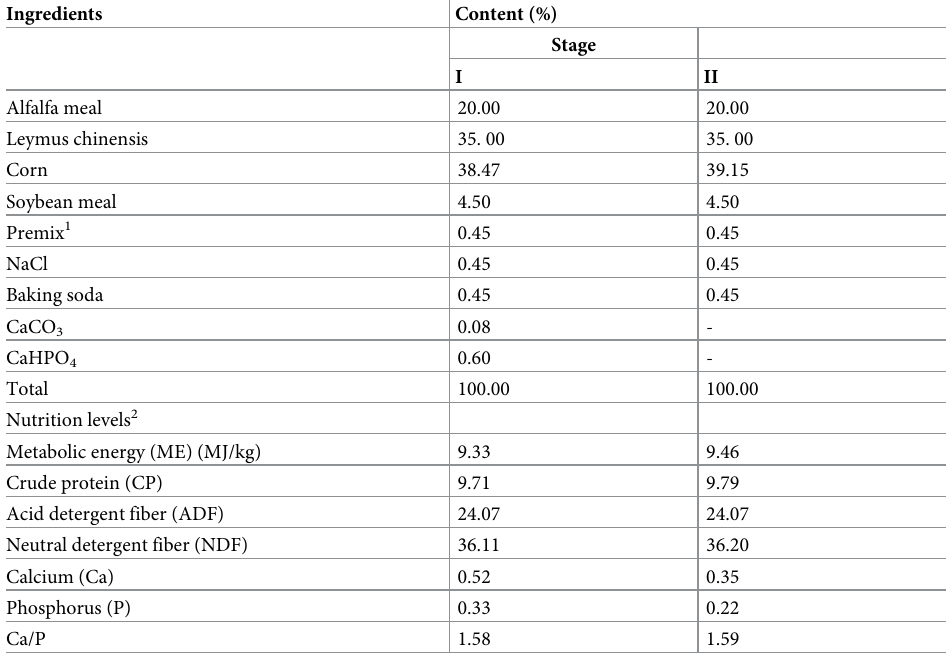
Premix provides the following per kg of the diet: Fe: (as ferrous sulfate) 30 mg, Cu: (as copper sulfate) 10 mg, Zn: